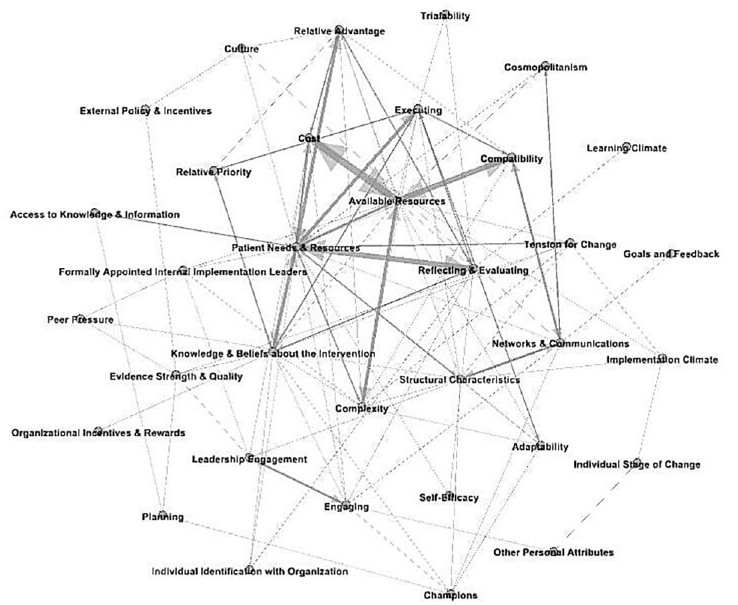
Fig 2. Key relationships between domains and constructs.